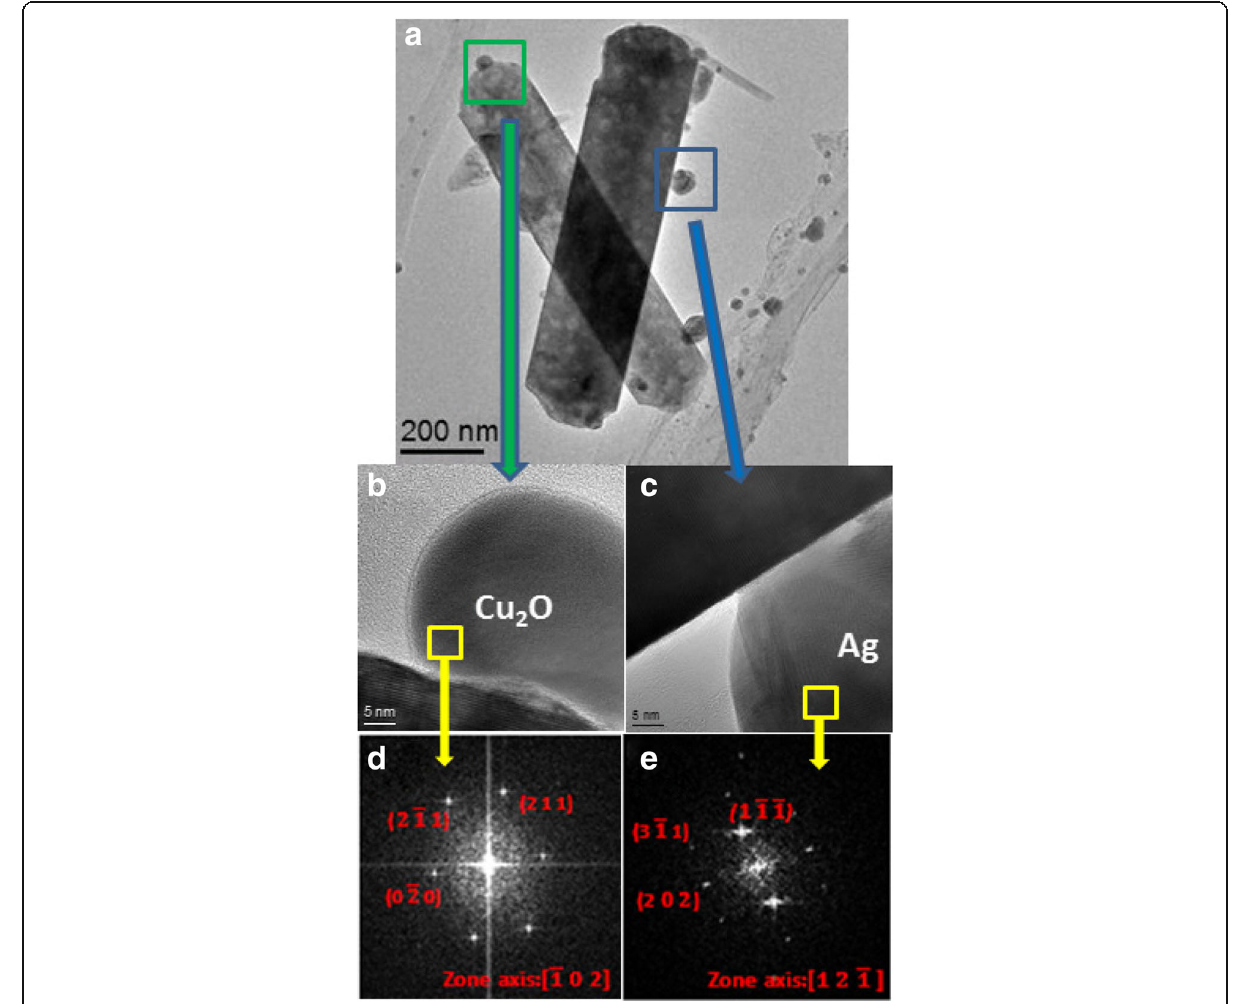
Fig. 3 a A TEM image of an Ag/Cu 2 O/ZnO NR. b , c High-resolution TEM images of a Cu 2 O and an Ag NP, respectively. d , e Fourier transform patterns of the